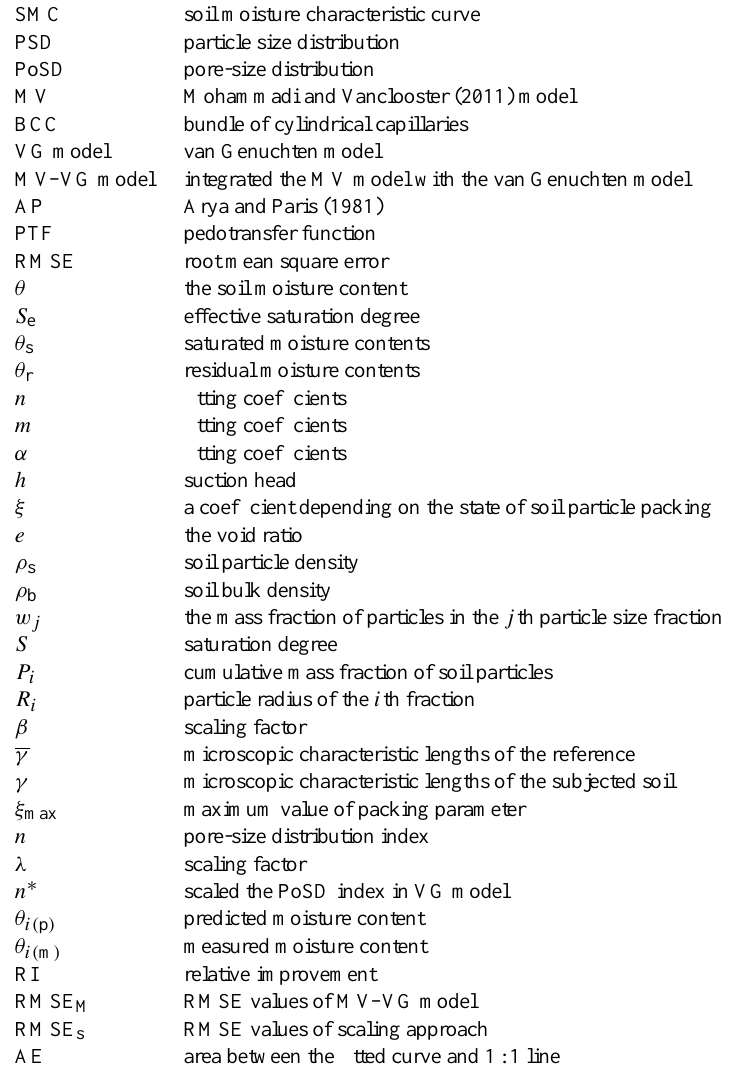
Table A1. Symbols and